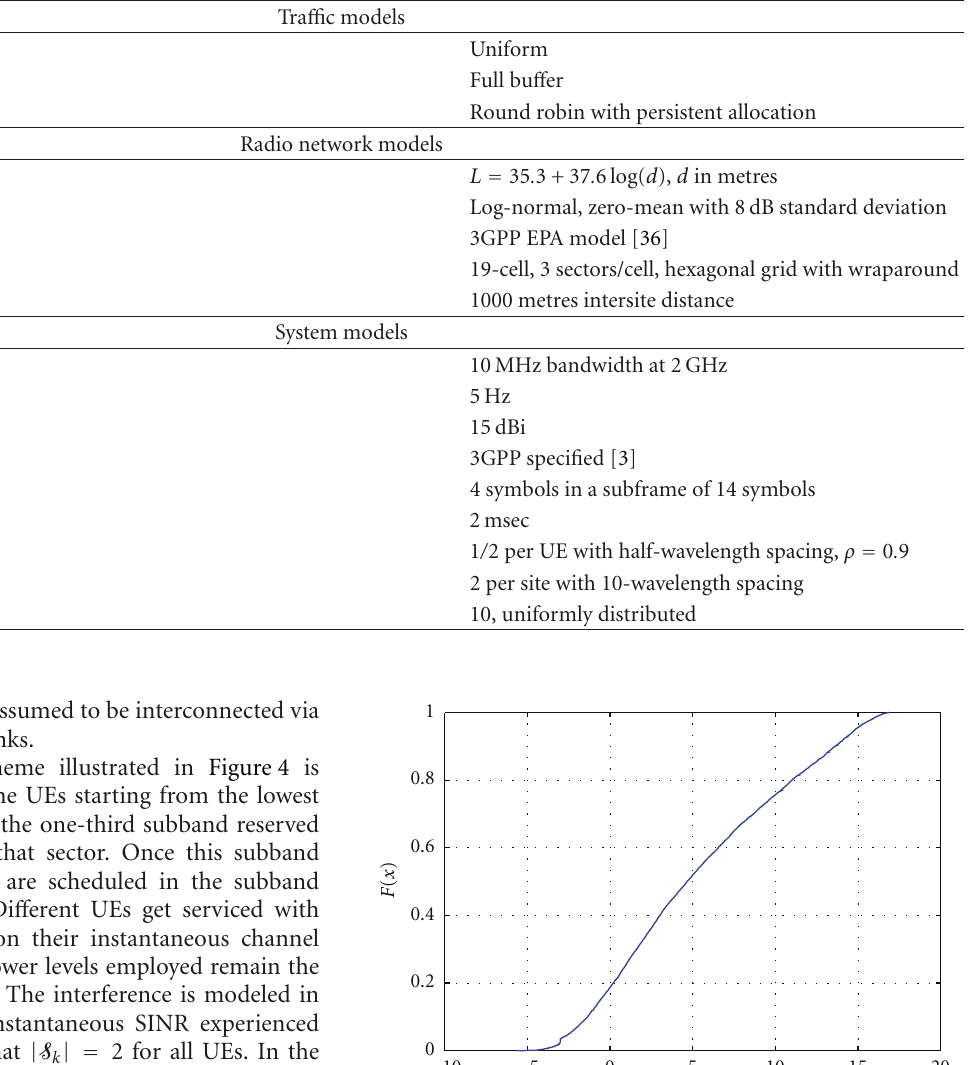
Table 2: Simulation parameters.